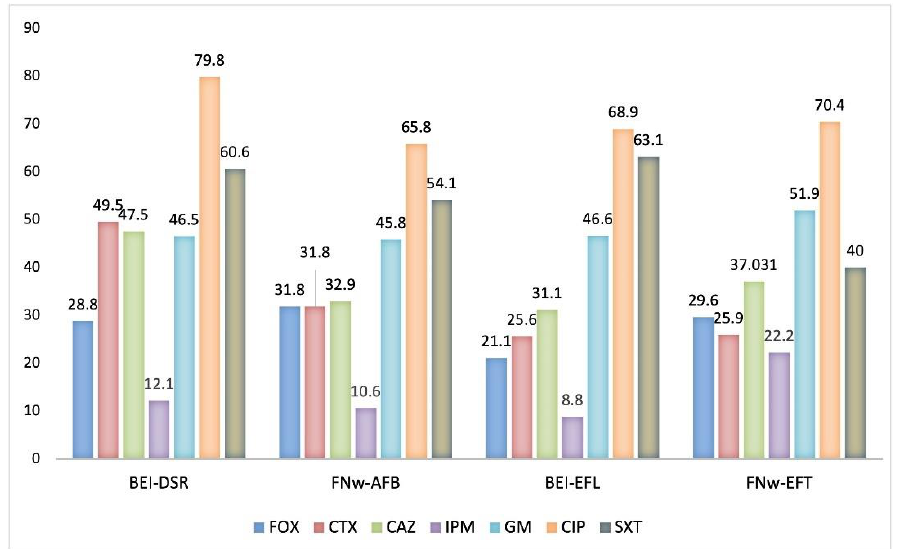
Figure 4. Percentage of resistant isolates of influent and effluent wastewater from the Beirolas and Faro Northwest WWTPs. Antibiotics tested: cefoxitin (FOX), cefotaxime (CTX), ceftazidime (CAZ), imipenem (IPM), gentamicin (GM), ciprofloxacin (CIP), and trimethoprim-sulfamethoxazole (SXT). BEI-DSR: Beirolas-Lisboa influent wastewater; BEI-EFL: Beirolas-Lisboa effluent wastewater; FNw-AFB: Faro Northwest-Algarve influent wastewater; FNw-EFT: Faro Northwest-Algarve effluent wastewater.